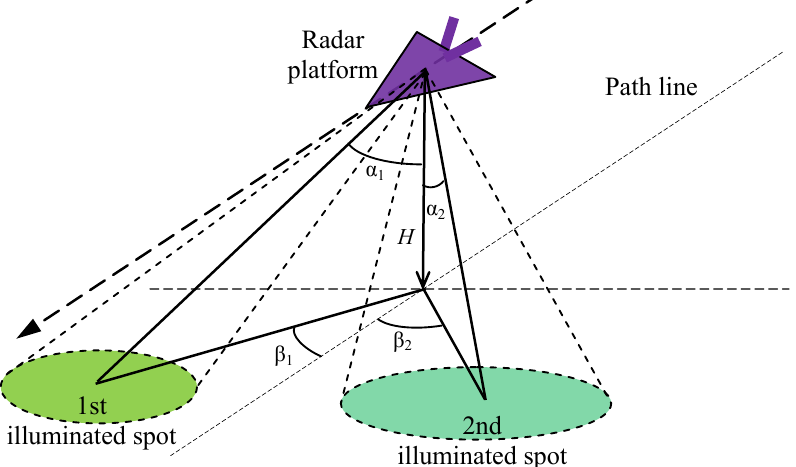
Fig. 3. The geometry of the radar scene and the antenna